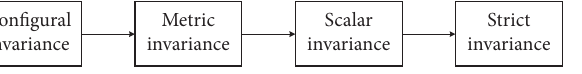
Figure 2: Flowchart of invariance tests.